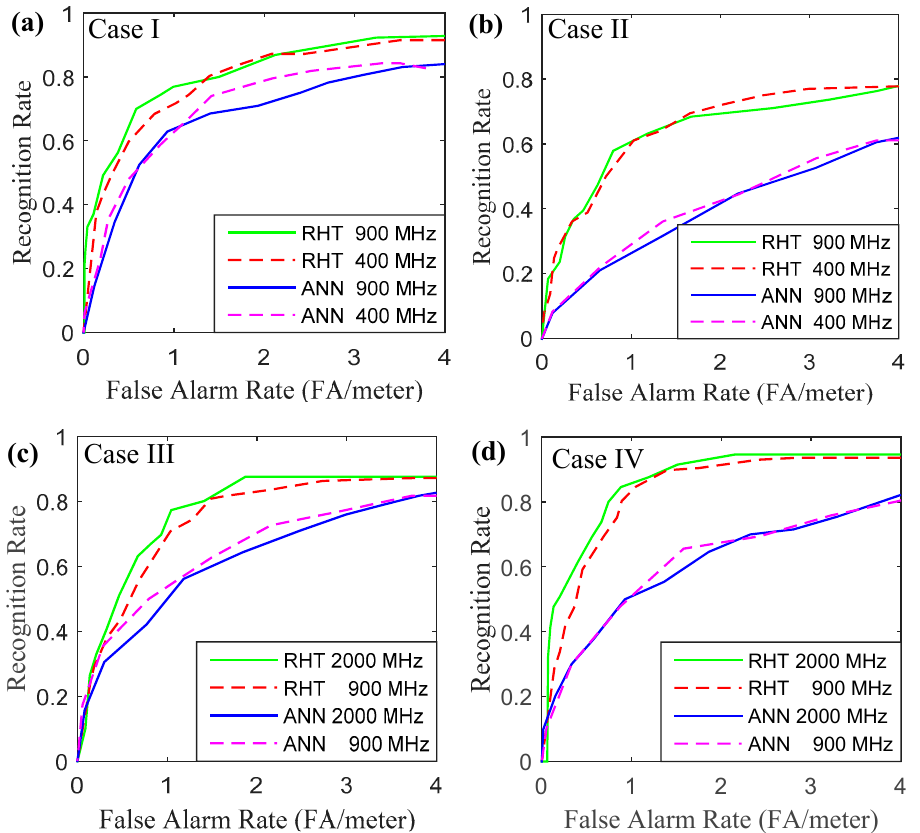
Figure 7. Receiver operating characteristic (ROC) curve for recognition results by RHT and ANN of the four in situ cases: ( a ) Case I in Xilingol League; ( b ) Case II in Jingbian; ( c ) Case III in Wushen Banner; and ( d ) Case IV in Otog Front Banner. Table 2. Accuracy of the four in situ cases.